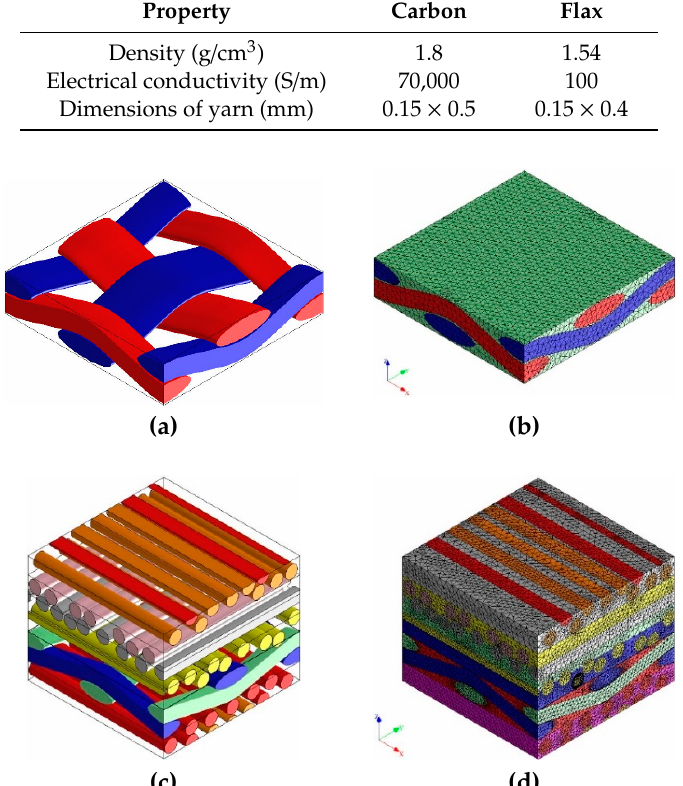
Figure 5. ( a ) RVE of CF / Rosin bio-composite (twill carbon fabric); ( b ) FE mesh of the RVE of Figure 5. (a) RVE of CF/Rosin bio-composite (twill carbon fabric); (b) FE mesh of the RVE of CF/Rosin CF / Rosin bio-composite; ( c ) RVE of CF / Flax-Resin bio-composite; ( d ) FE mesh of the RVE of bio-composite; (c) RVE of CF/Flax-Resin bio-composite; (d) FE mesh of the RVE of CF/Flax-Resin bio- CF / Flax-Resin composite.